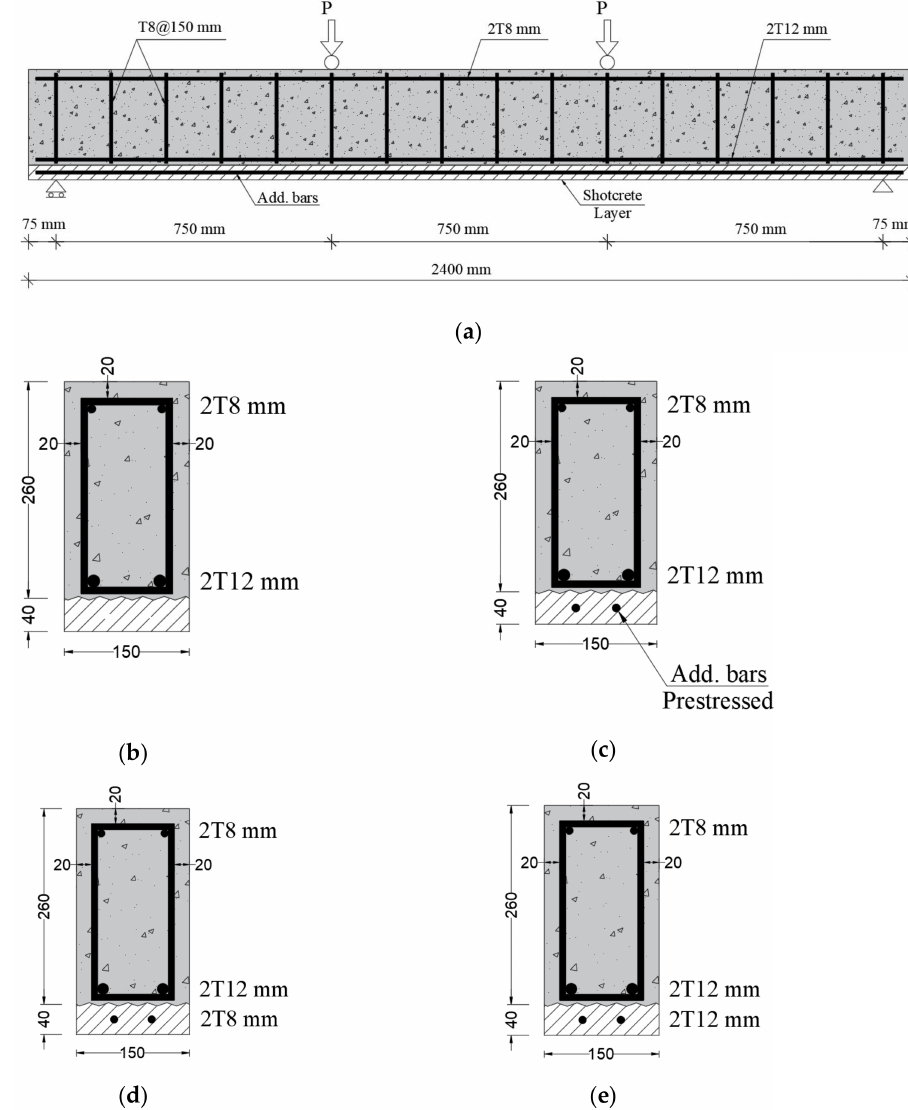
Figure 10. Details of specimens of the parametric study. ( a ) Four-point loading test setup, cross- sectional details of ( b ) control beam, ( c ) Pre-stressed Beam, ( d ) Reference Beam 1, ( e ) Reference Beam